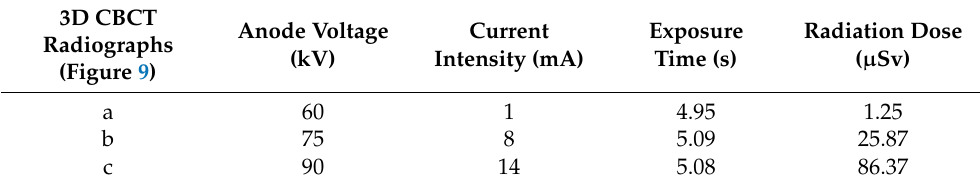
Table 3. 3D CBCT setting before and during every step of the optimization process presented in Figure 9.